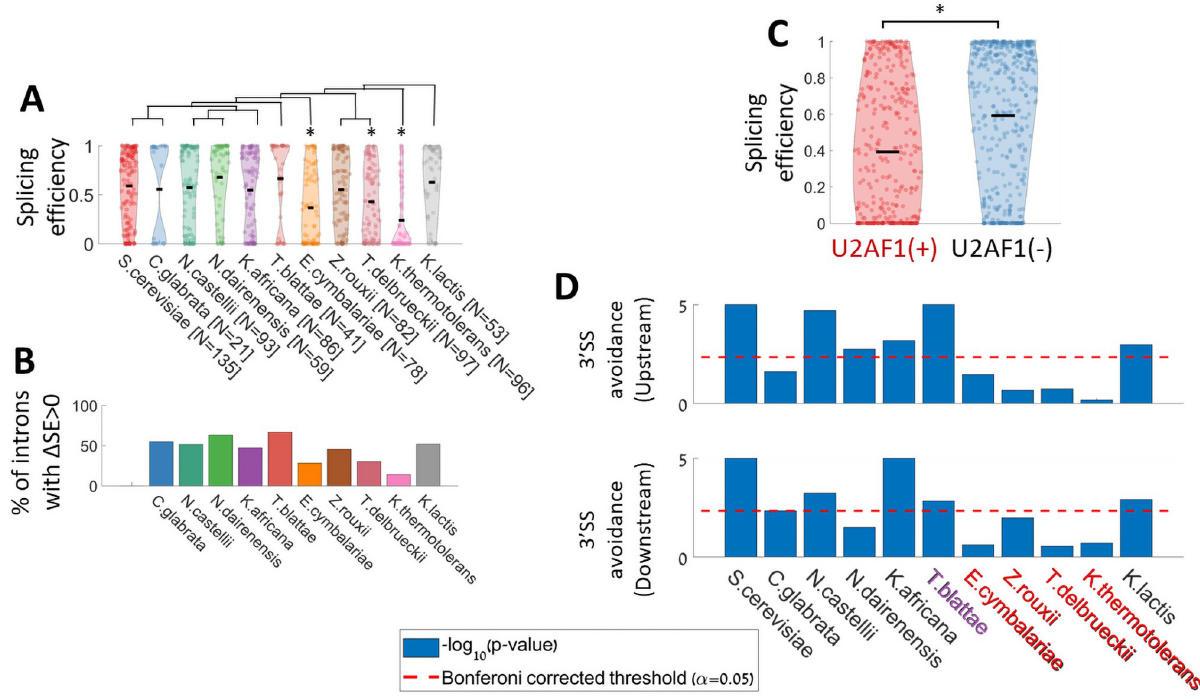
Fig 6. Analysis of ortholog introns from other yeast species reveals intron architecture evolution. A. Splicing efficiency distribution of spliced variants of S . cerevisiae natural introns and orthologs of S . cerevisiae intron-containing genes. A species phylogenetic tree (created according to [60]) is presented above the corresponding violins. The number of introns included in the library from each species is indicated after each species name. Asterisks mark origin species with splicing efficiency distribution significantly lower than that of S . cerevisiae ’s introns (t-test, p value < 0.001). B. Percent of introns that are spliced better than their S . cerevisiae ortholog intron for each species. C. Splicing efficiency distribution for introns that come from species that have a functional copy of U2AF1 splicing factor (left), and introns that come from species without U2AF1 splicing factor (t-test, p- value < 10 − 9 ). D. Hypothesis test for the 3’SS motif avoidance for each of the 11 species upstream (top) or downstream (bottom) to the 3’SS. P-value was calculated by comparing the mean frequency of the 3’SS motif at a 30nt window upstream/downstream to the 3’SS against 10 5 sets of sequences each composed of coding genes sequences registered according to randomly chosen positions. Species with a copy of U2AF1 are marked in red, species with malfunctioned U2AF1 are marked in purple, and species without any copy of U2AF1 are marked in black.